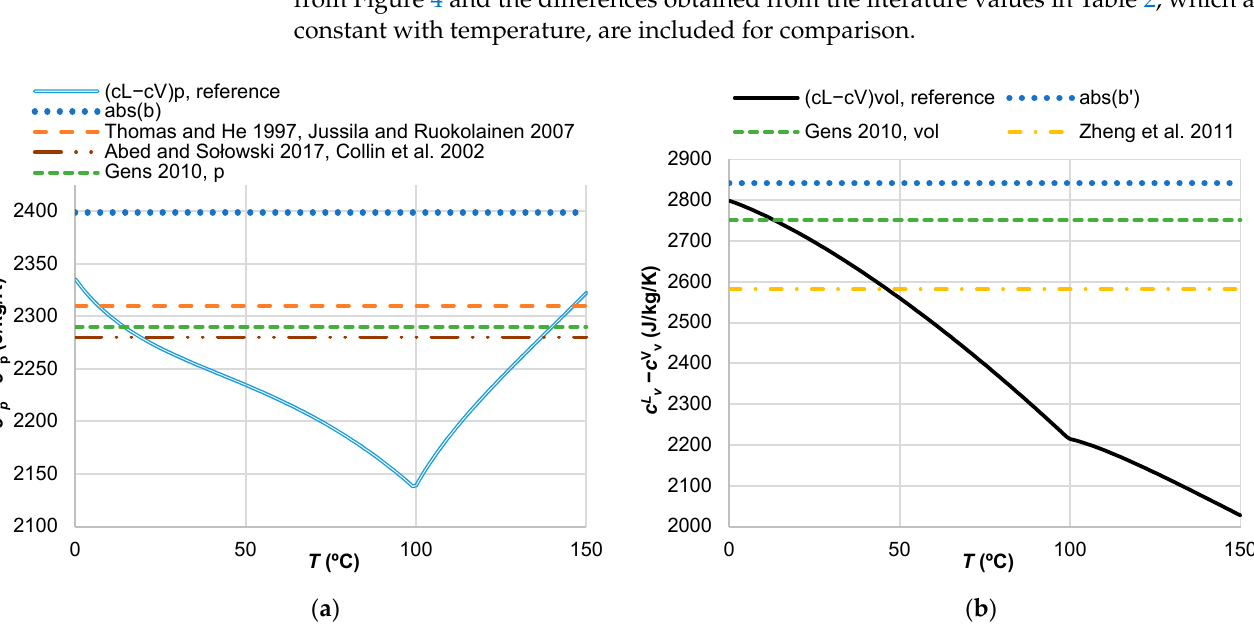
Figure 5. Specific heat capacity c of liquid (L, solid lines) water and water vapour (V, dashed lines) for the temperature range 0–150 °C, at the minimum between saturation pressure and 100 kPa, for isochoric (vol, black) and isobaric (p, blue outline) conditions. All values from the NIST [13] .